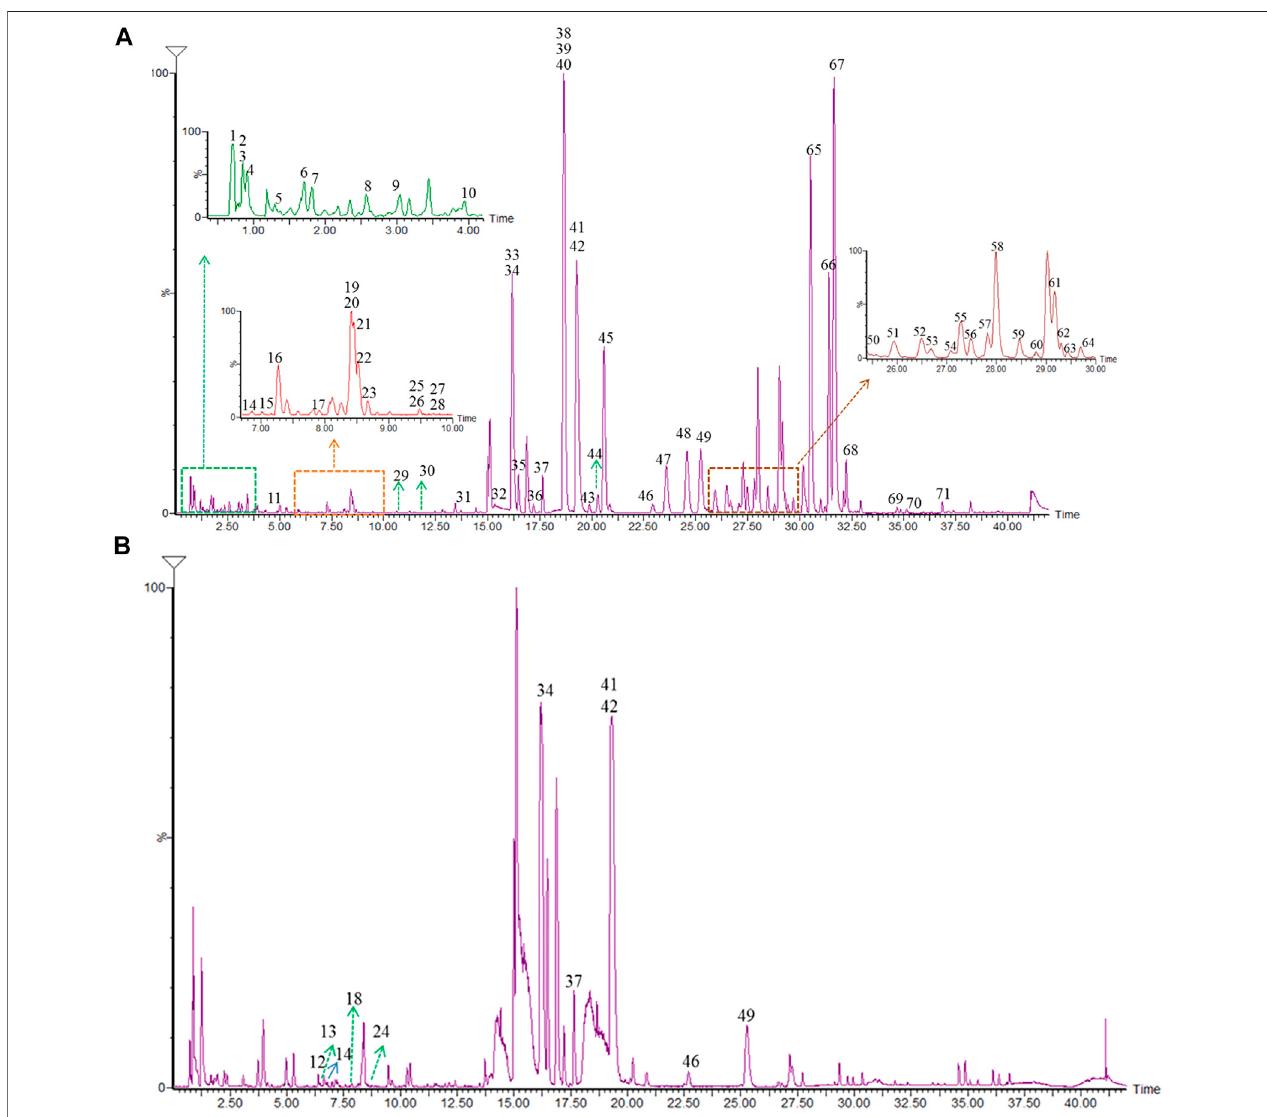
FIGURE 3 | BPC of Hugan tablets in both positive (A) and negative (B) ion modes.